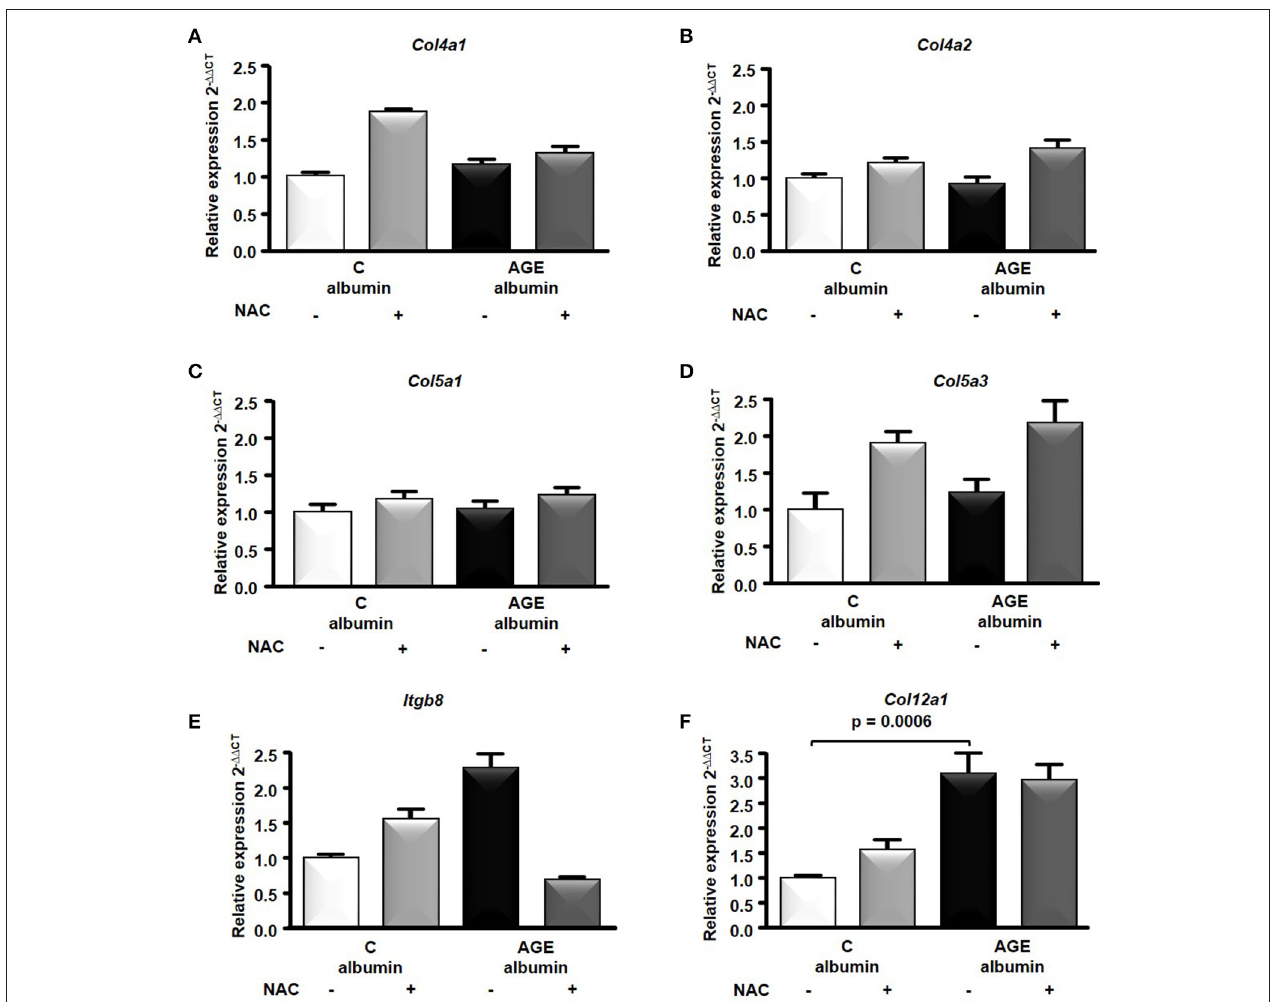
FIGURE 8 | RNA-seq of the periepididymal adipose tissue. Col4a 1 (A) , Col4a2 (B) , Col5a1 (C) , Col5a3 (D) , Itgb8 (E) , Col12a1 (F) mRNA were validated in periepididymal adipose tissue from animals treated with C ( n = 7) or AGE- albumin ( n = 8) by real time quantitative PCR (RT-qPCR; Applied Biosystems, Foster City, CA, USA). The relative expression of each gene was normalized to the housekeeping Hprt1 and relative quantification analysis was performed using the comparative cycle threshold (Ct) (2 − 11 Ct ) method. Results (mean ± SEM) were compared by One-way ANOVA with Newman-Keuls post-test or Kruskal-Wallis followed by multiple Dunns